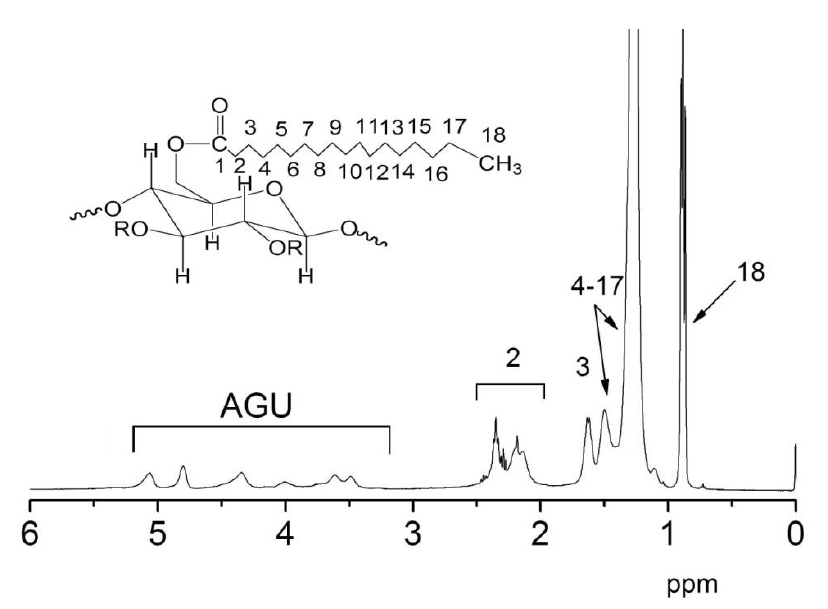
Figure 3. 1 H-NMR of